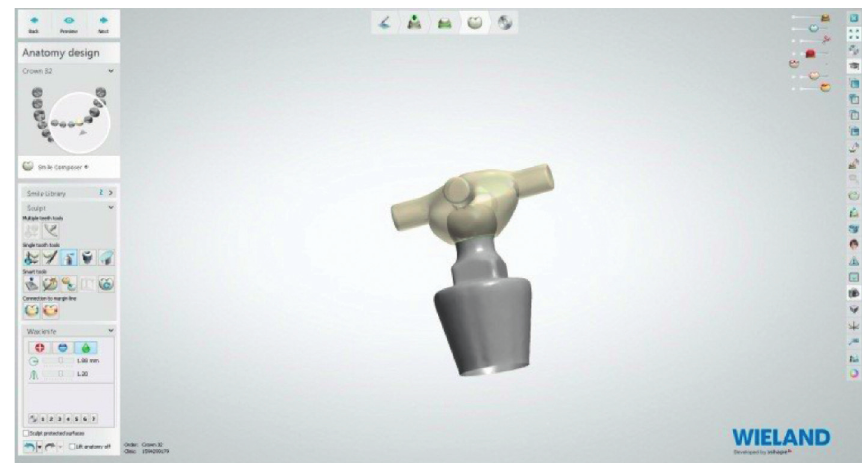
Figure 4: PEEK cap adapted to ball abutment.